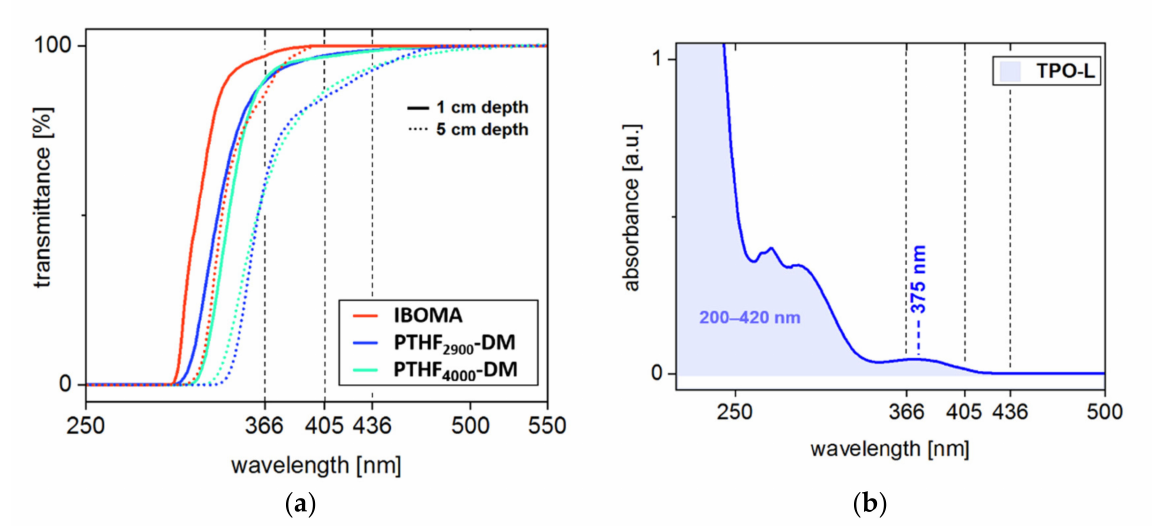
Figure 4. ( a ) Pure monomers are highly transmissive to the major output lines of the medium pressure mercury lamp at 366, 405, and 436 nm, respectively. With increasing film thickness, the intensity of the i-line (366 nm) is attenuated by PTHF-DM monomers to about 50% in five centimeters depth. ( b ) The absorbance maximum of TPO-L around 375 nm captures the i-line (366 nm) and the h-line (405 nm) emitted by the medium pressure mercury lamp.